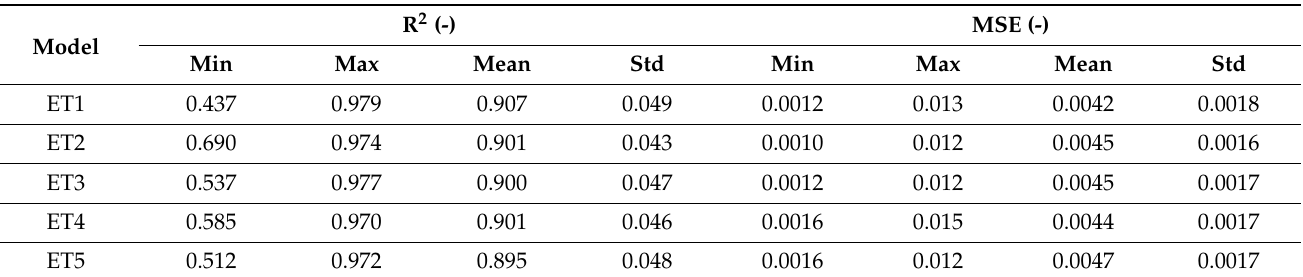
Figure 7. Results of the Monte Carlo simulations for models ET1–ET5: ( a ) changes of MSE for testing dataset, ( b ) normal distribution fitting of MSE, ( c ) changes of R 2 for testing dataset, ( d ) normal distribution fitting of R 2 . Table 7. Summary of error criteria of the MCS for the testing dataset.